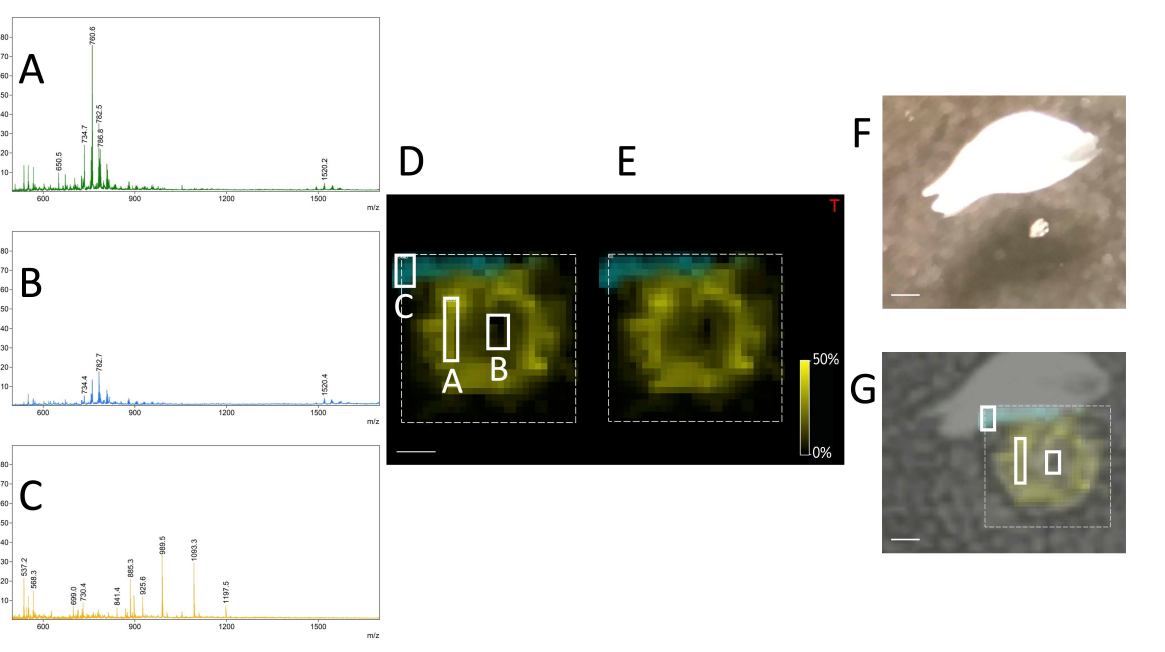
Figure 14. The comparison of the spectra obtained from different parts of the image of the oocyte washed with PBS ( A )—spectrum from the splashed part of the cell (the intensity of the signal is increased), ( B )—the signal directly from the cell (the inner part), ( C )—the signal from the nail polish—the indicator of oocyte position, ( D )—the picture of the oocyte with the marked region from which the spectra were created, ( E )—overall view of the MSI image, ( F )—the photo of the oocyte on the ITO glass, ( G )—the photo of the same oocyte covered with matrix and overlapped by the MS image, size bar: 200 µ m.